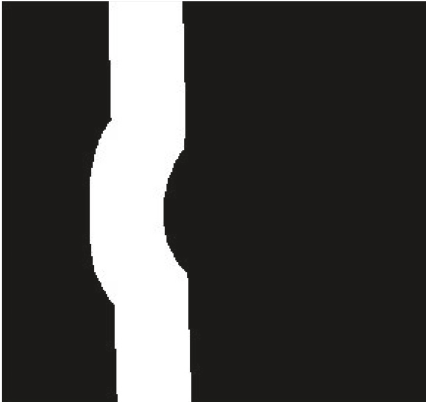
Figure 7: Single laser height reconstruction.